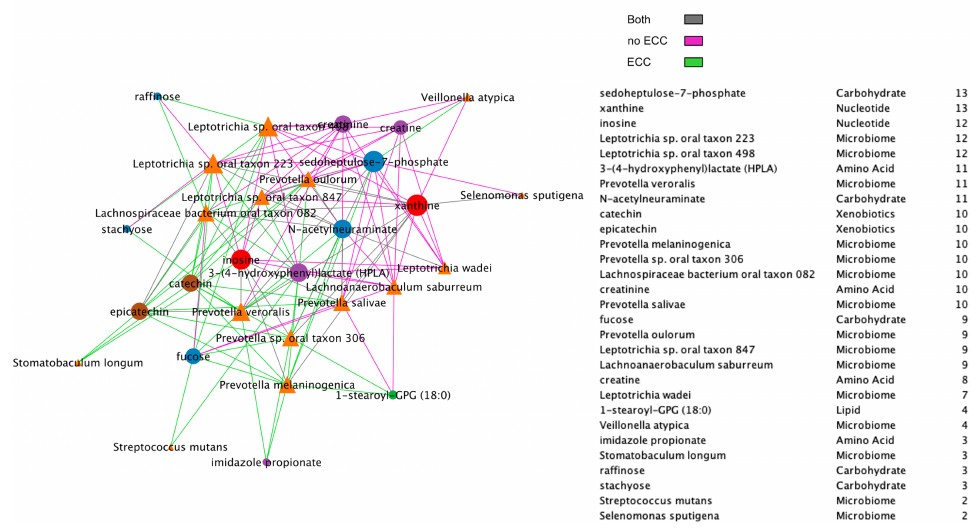
Figure A7. Heatmap of species-wise standardized counts illustrating species modules identified by spectral clustering (shown as the two top bars). Columns represent individual species and are ordered by the clusters predicted from the affinity matrix based on the BZINB correlations between species in the disease (ECC) group. Columns are annotated to show and compare the predicted clusters between healthy (no ECC) and disease (ECC) groups. Each row represents a participant (n = 289). The rows are ordered based on hierarchical clustering and are annotated to illustrate healthy and disease groups and the sequencing batch. Standardized counts were calculated separately for each species by first suppressing outliers (defined by greater than 3 × IQR from the first or third quartile), then centering around the median and dividing by the standard deviation.